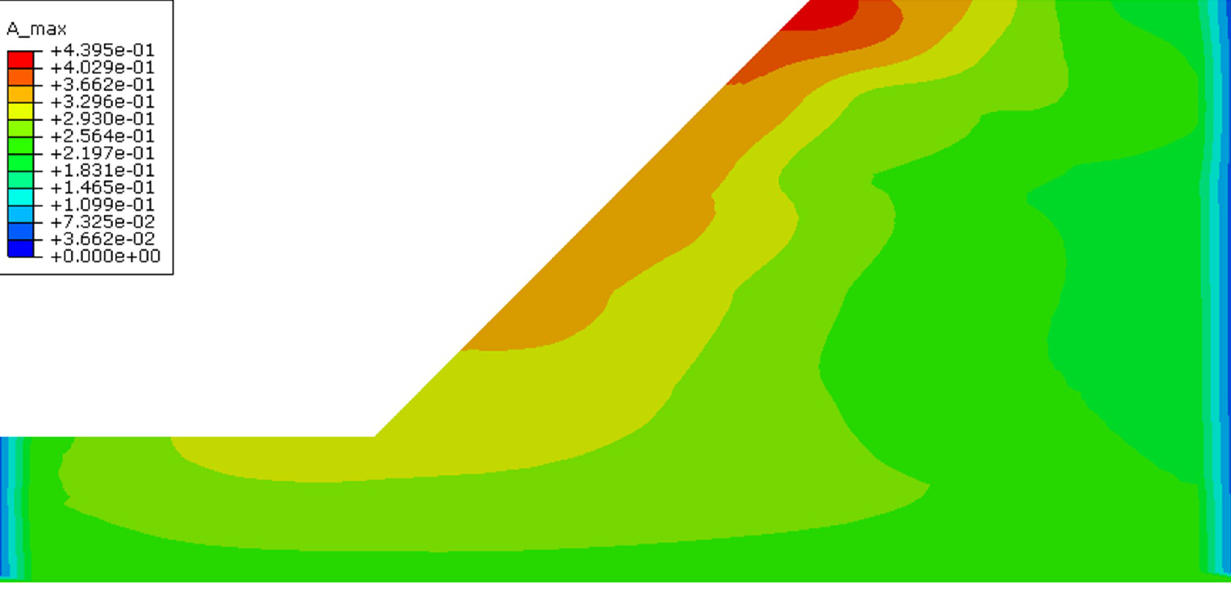
PLOS ONE | https://doi.org/10.1371/journal.pone.0254871 July 30,